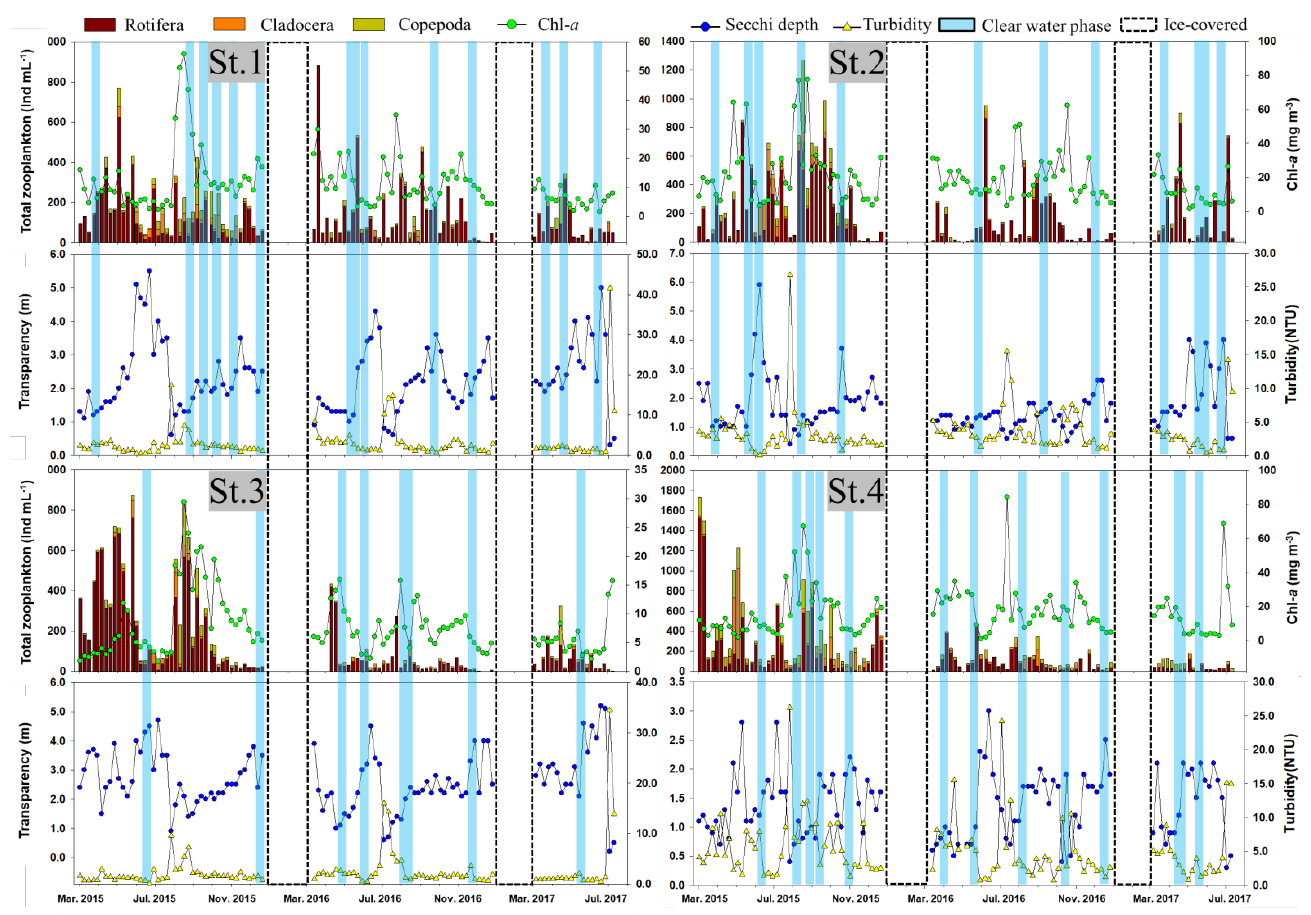
Figure 3. Environmental variables showing significant differences among the four sites in Lake Paldang studied from March 2015 to July 2017. 2015 to July